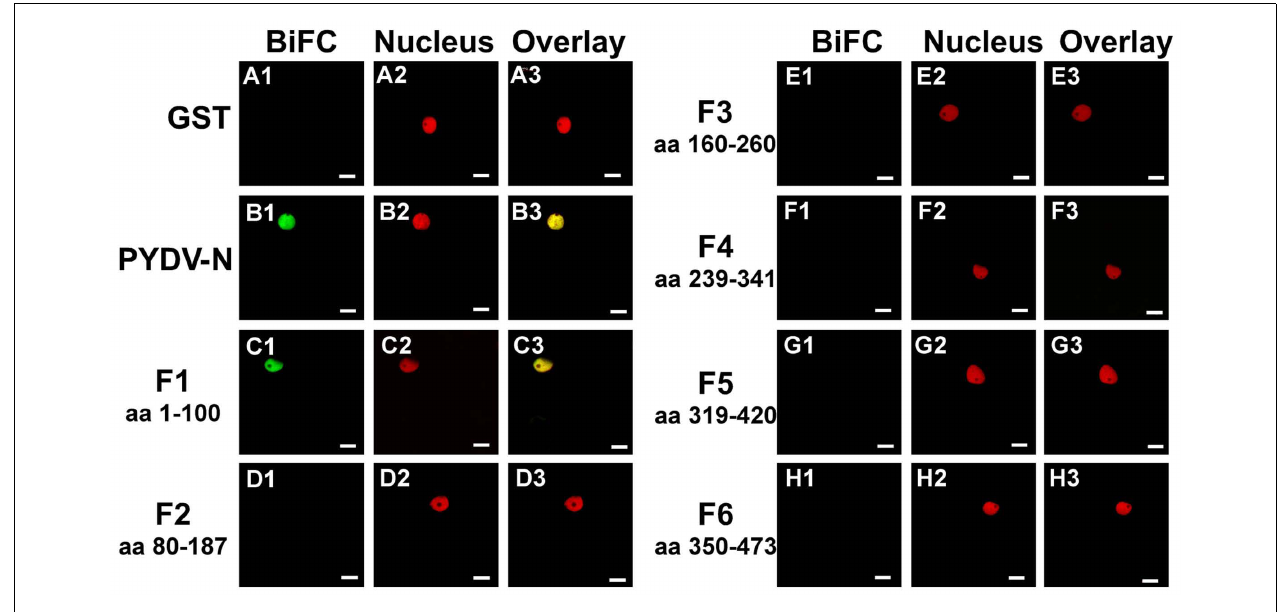
FIGURE 8 | Confocal micrographs showing PYDV-N fragment interactions with PYDV-N determined by BiFC. Interaction assays were conducted in leaf epidermal cells of transgenic N. benthamiana expressing a fluorescent nuclear marker (Nucleus). Shown is the ability of fragments of